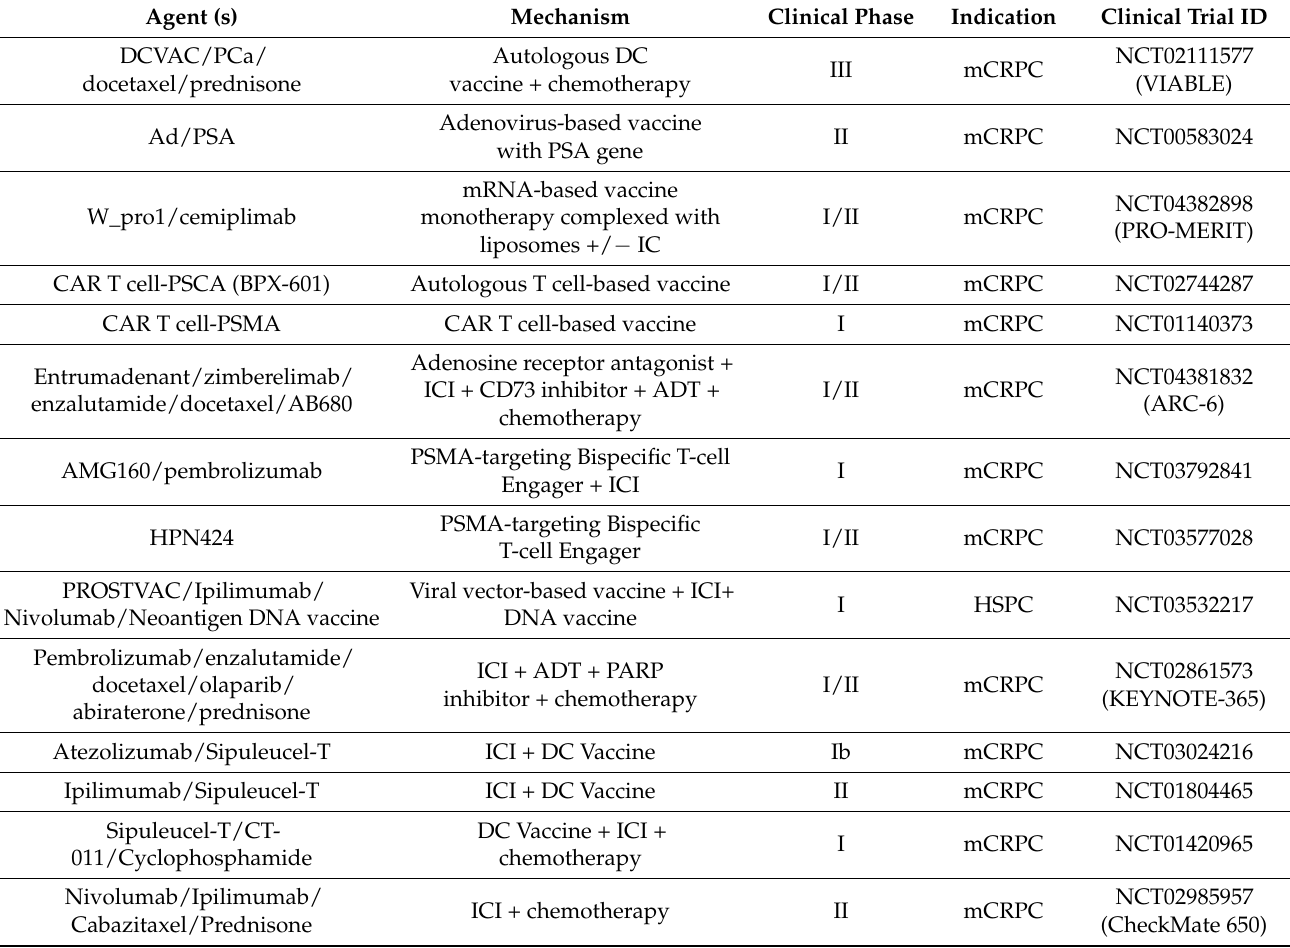
Table 1. Current ongoing clinical trials of immunotherapeutics in prostate